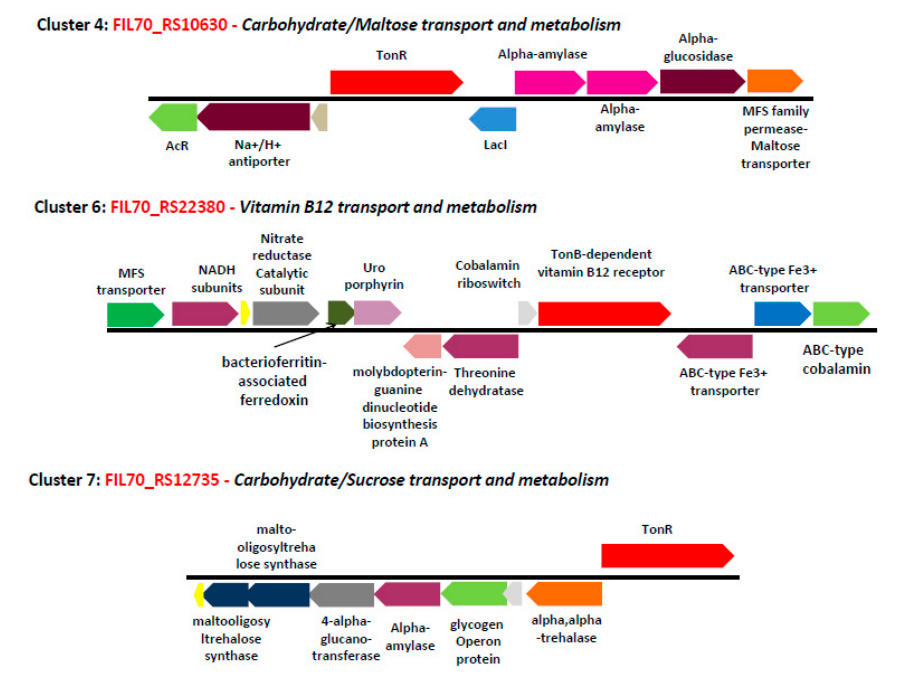
Figure 3. Genome-context analysis of Sphingobium fuliginis TBDTs found in clusters 4, 6, and 7.